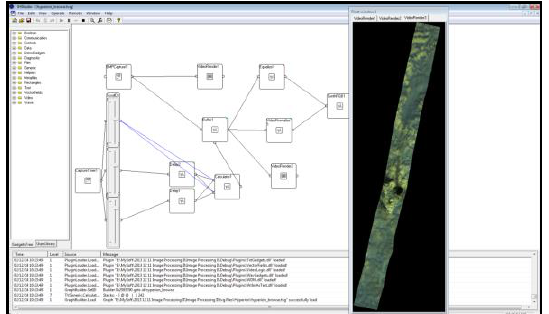
Figure 7. Interface of dynamically generating tools for HSD analysis built using Stream Handler technology